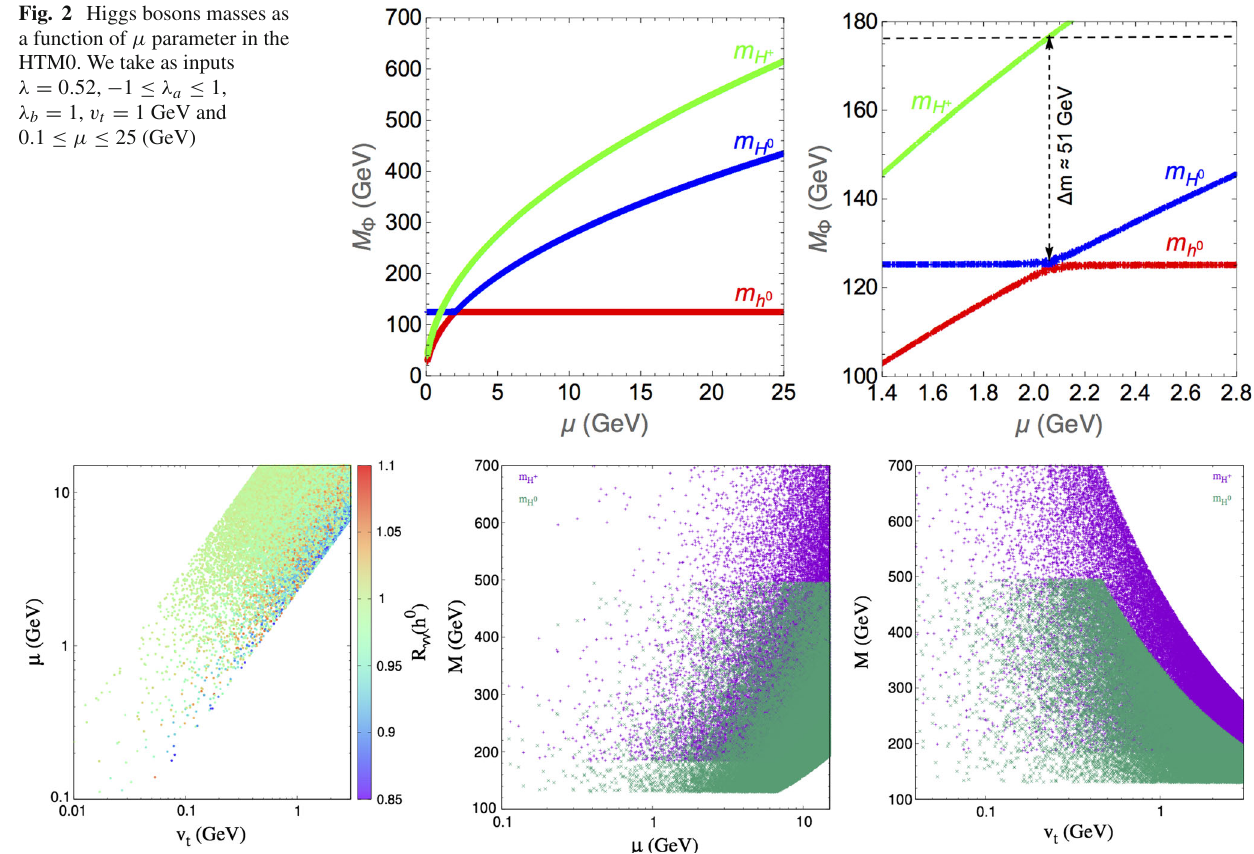
Fig. 3 R γγ ( h 0 ) variation in the ( μ,v t ) plane (left), H 0 and H ± Higgs bosons masses as a function of μ (middle) and of v t (right). Inputs are: λ ≈ 0 . 52 ( m ≈ 125 GeV), | λ | ≤ 1 . 5, | λ | ≤ 1, 10 − 2 ≤ μ ≤ 25 (GeV) and 10 − 2 ≤ v a b h 0